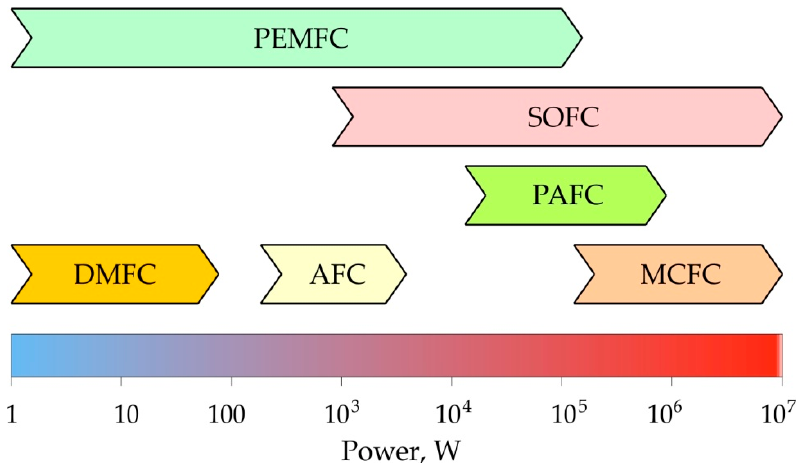
Figure 14. Power generated by different fuel cells.